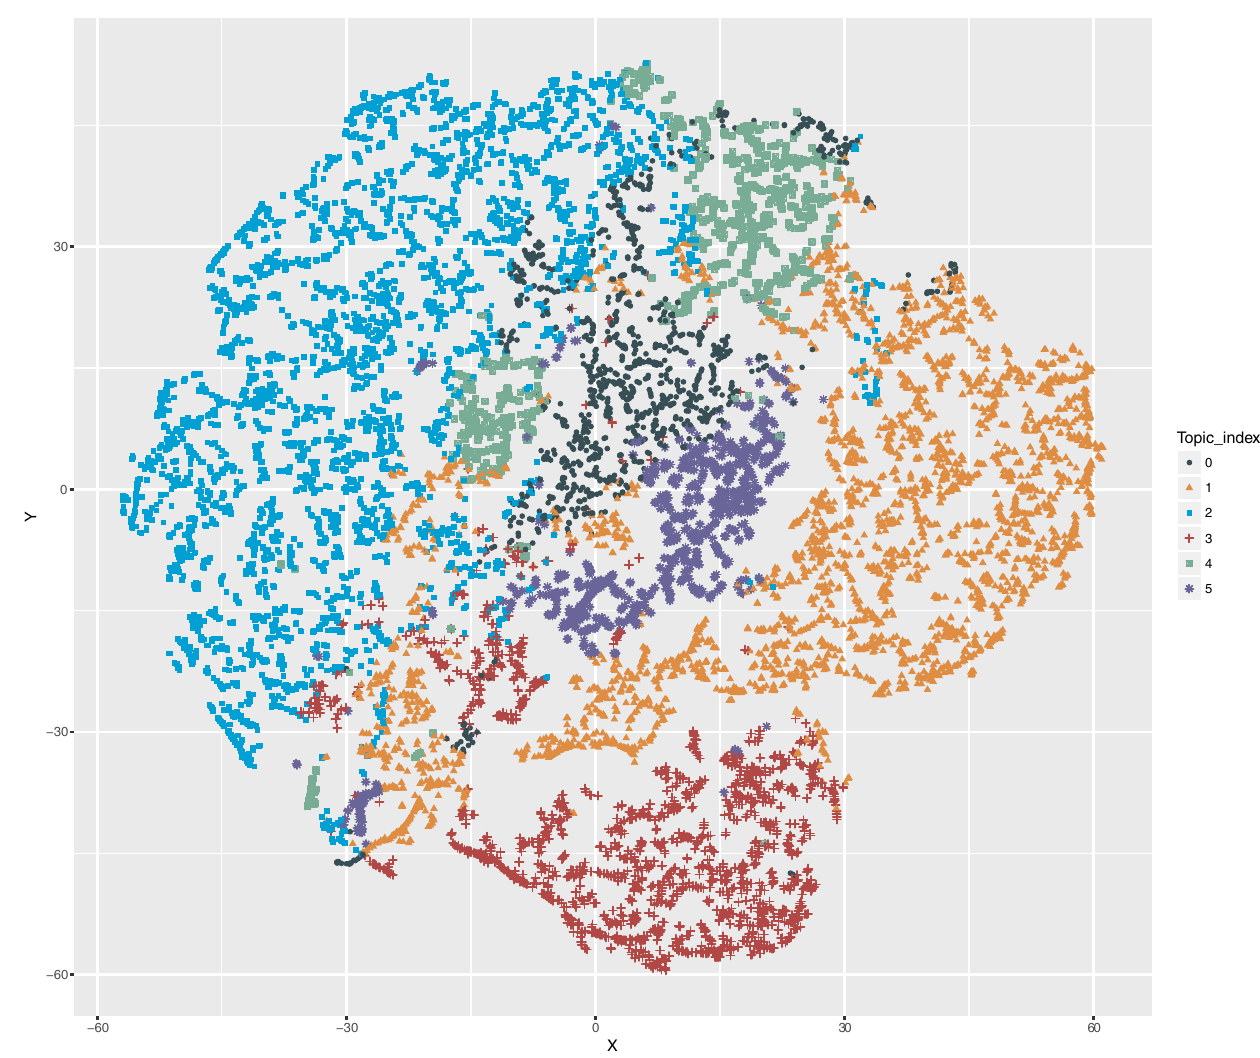
Fig 4. t-SNE plot of visualizing the patient clusters in a projected 2D metric map (The perplexity was set to 30).